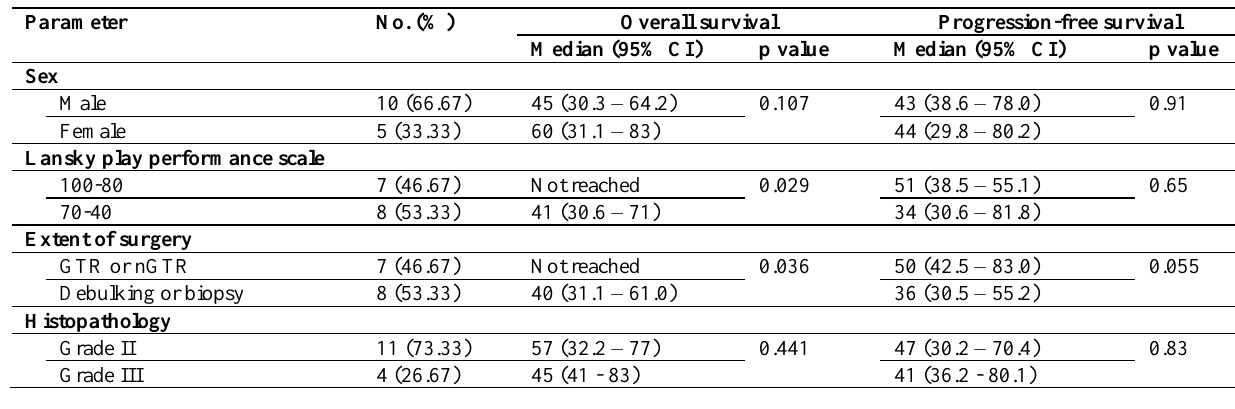
Table 4: Influence of different clinical features on survival rates Parameter